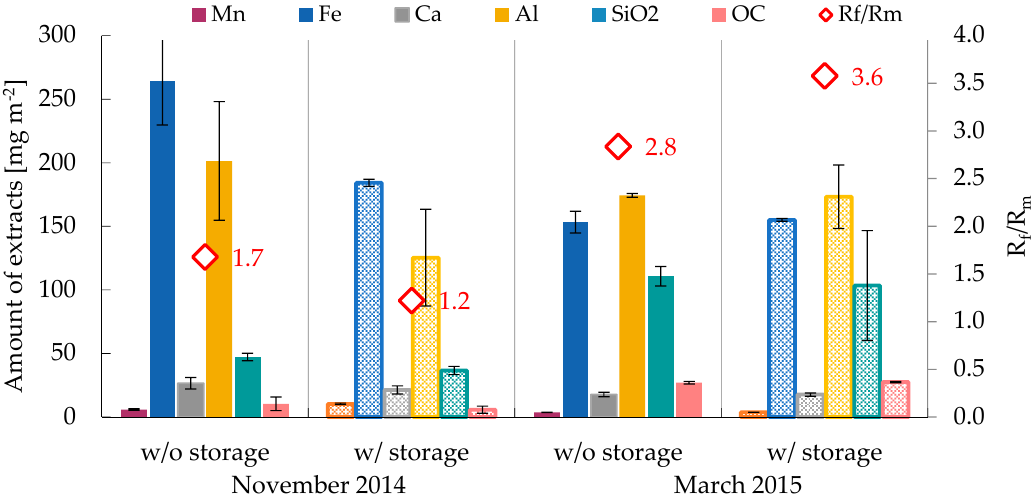
Figure 8. Total extracted foulants from used membranes in November 2014 and March 2015. Open diamond symbols show the average fouling resistance (R f / R m ) in each experimental